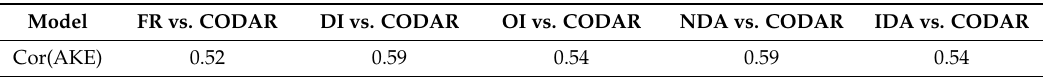
Table 3. Correlation of AKE of surface vector